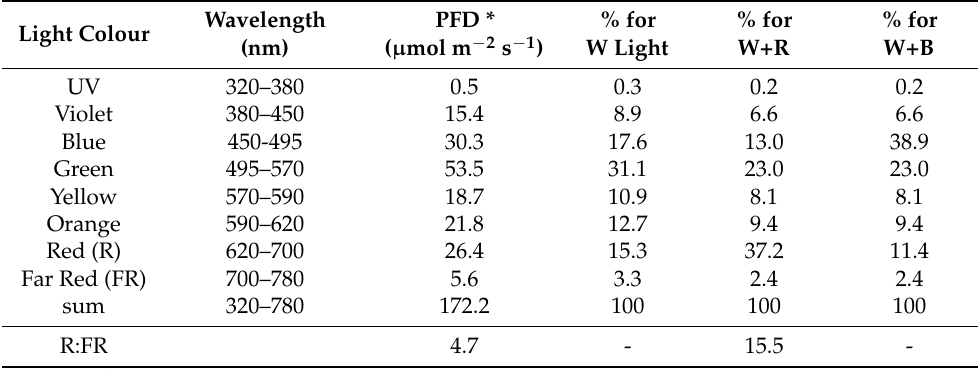
Figure 1. Spectral photon distribution of LEDs light sources: ( a )—blue light; ( b )—red light; ( c )—white light. Table 1. Characteristics of white light